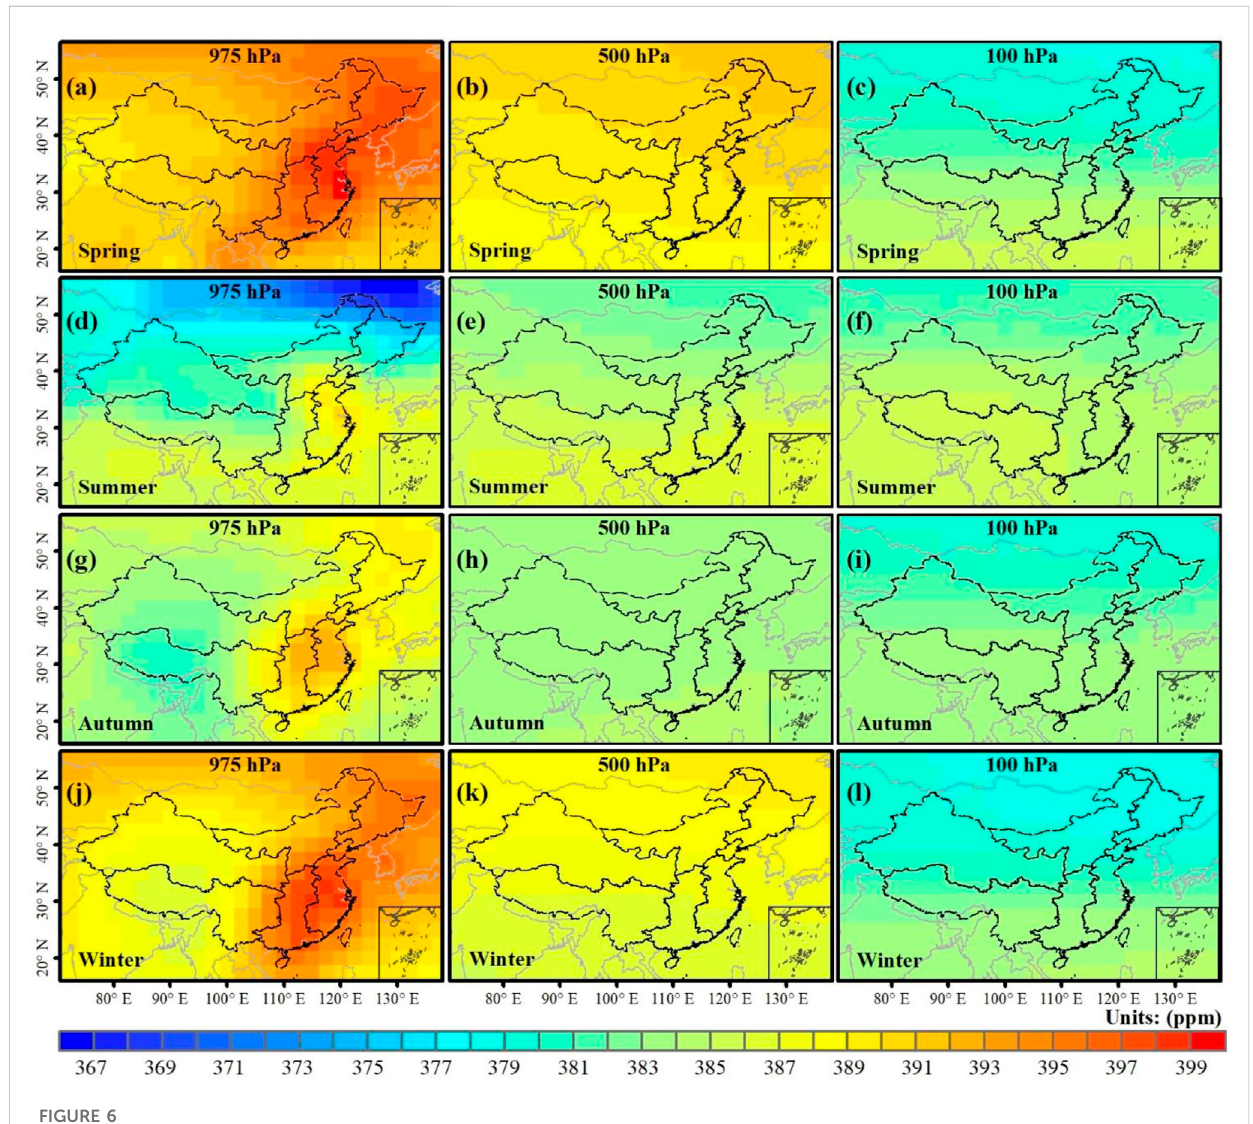
FIGURE 6 Spatial patterns of CO 2 concentrations at four seasons for the three typical